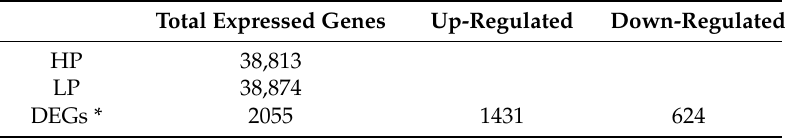
Table 2. Gene number identified through RNA-seq analysis. Total Expressed Genes